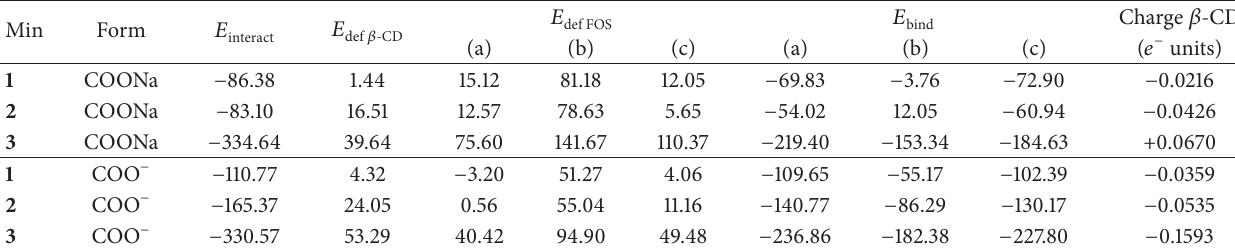
Table 2: The interaction, 𝐸 , deformation, 𝐸 def 𝛽 (host, 𝛽 -cyclodextrin), 𝐸 (guest, fosinopril), 𝐸 binding energies (kJ/mol), interact -CD defFOS bind and the charge on the 𝛽 -CD molecule calculated for the three possible optimal geometries of the FOS/ 𝛽 -CD complex, using PM3 calculation results for the two possible forms (salt and ionic) of fosinopril and the three conformations taken to account for free FOS: (a) the nearest stable conformation to the crystal structure; (b) the global minimum energy conformation; (c) the nearest stable conformation to the FOS geometry in the complex; 1 , 2 , and 3 correspond to the three energy minima obtained by MM+